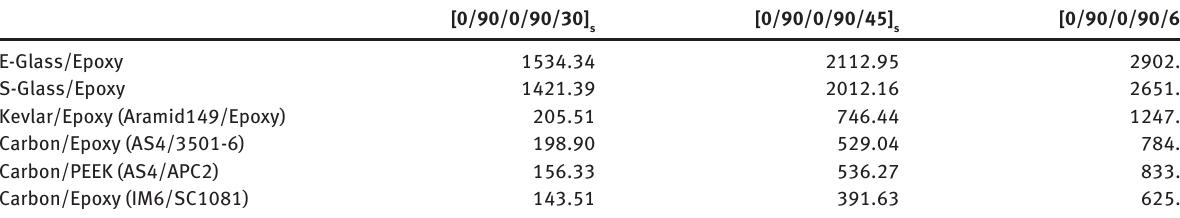
Table 10 Comparison of the critical energy release rate G (N/m) obtained from meshfree methods (Nodes: 11 × 19).